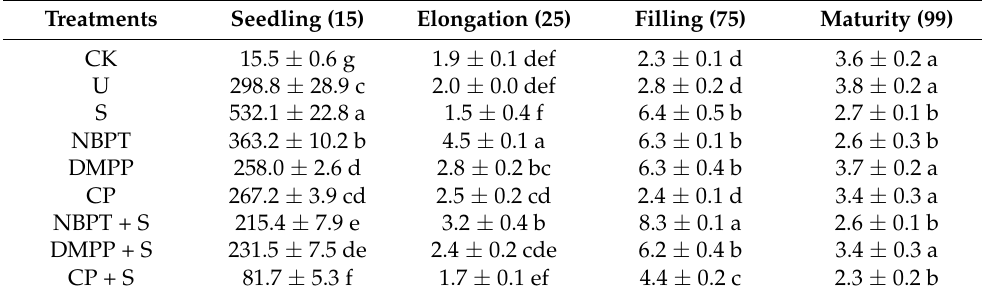
Table 3. Contents of NO 3 − -N of different treatments in soil (mg kg − 1